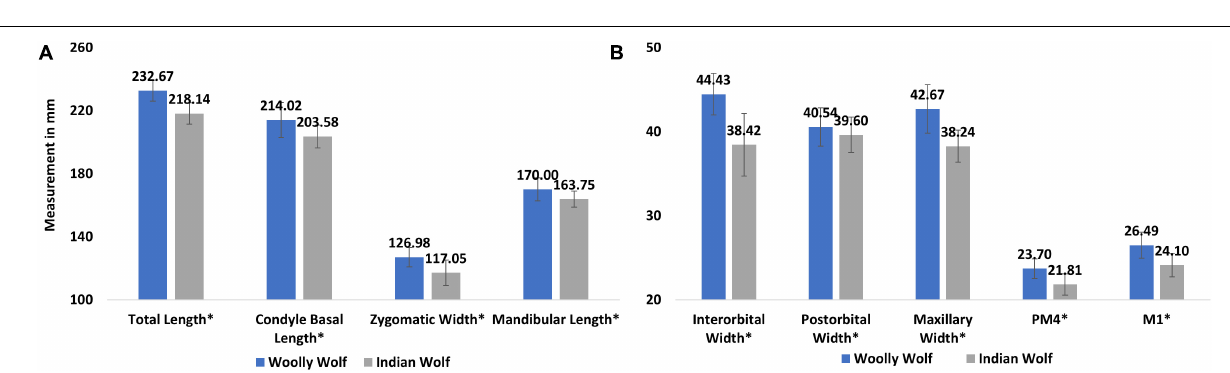
FIGURE 6 | Comparison of different cranial measurement of eight Woolly and eight Indian wolves obtained from Allen (1938), Pocock (1941), and Srinivas and Jhala (2021) (A) measurement of total length, condyle basal length, zygomatic width and mandibular length, (B) measurement of inter and post-orbital, mandibular width, length of pre-molar4 and molar 1. *The difference between the sub species of wolves were found statistically